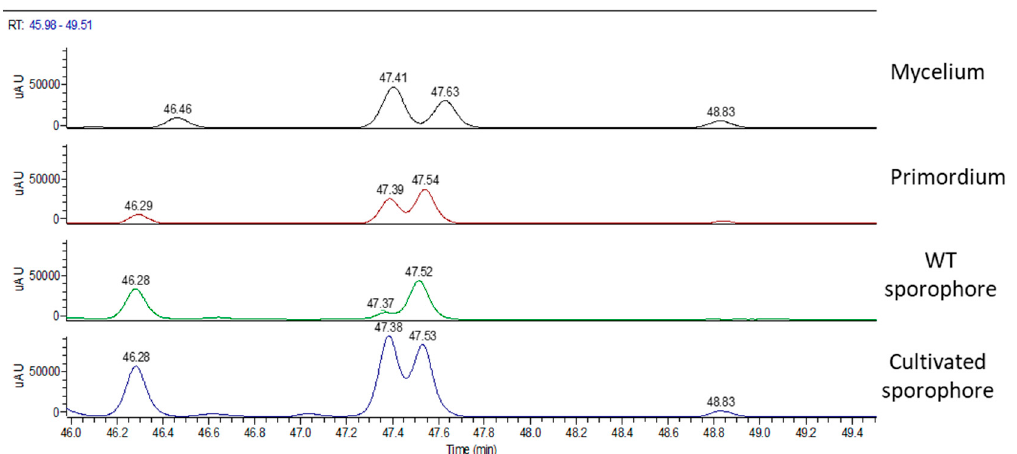
Figure 9. UV chromatographic traces of hericenes in (from top to bottom) mycelium, primordium, and wild type and cultivated sporophores.